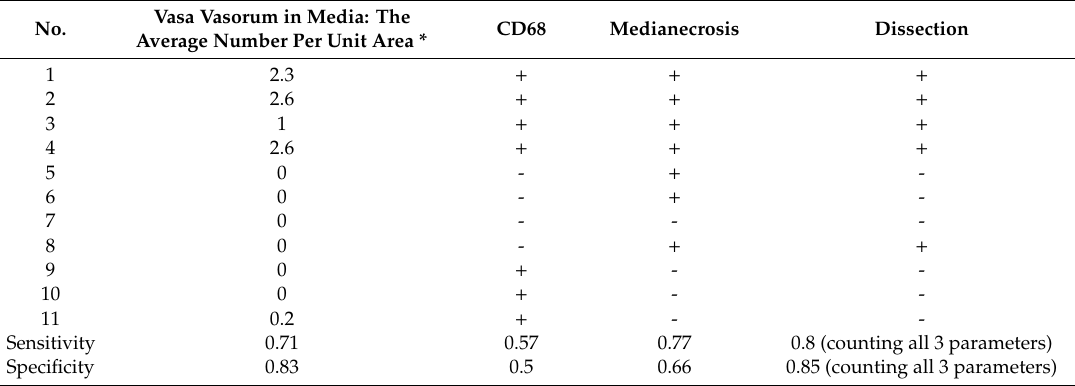
Table 2. Patients with aortic aneurysm, morphological characteristics of the